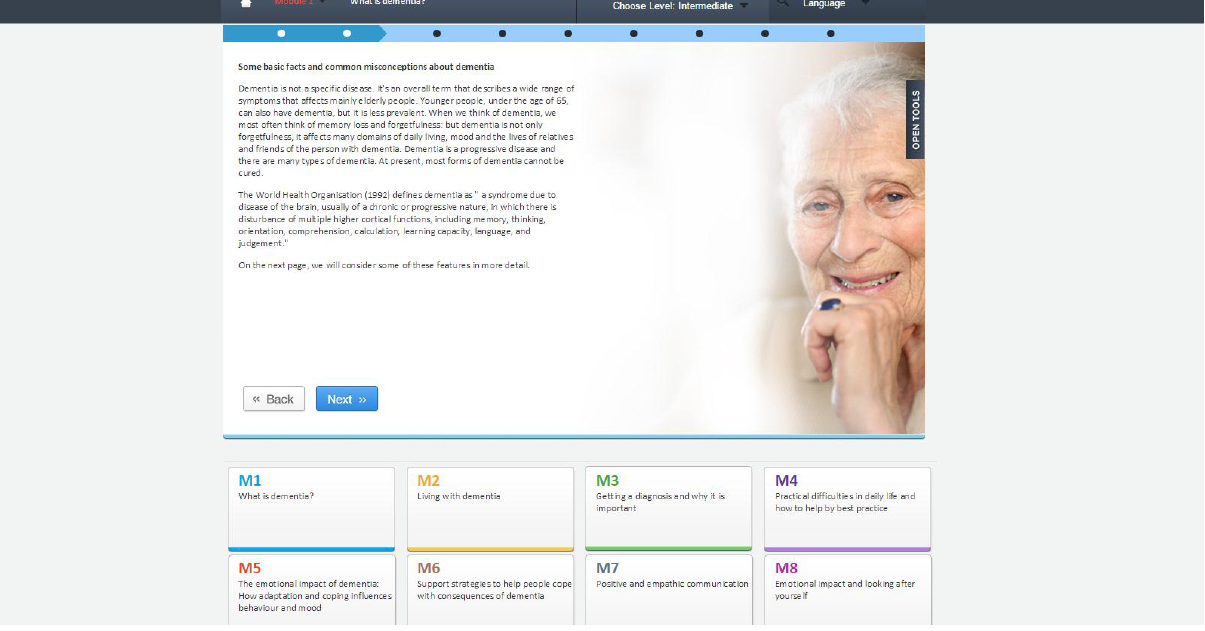
Figure 3. Example of a module (module 1: What is